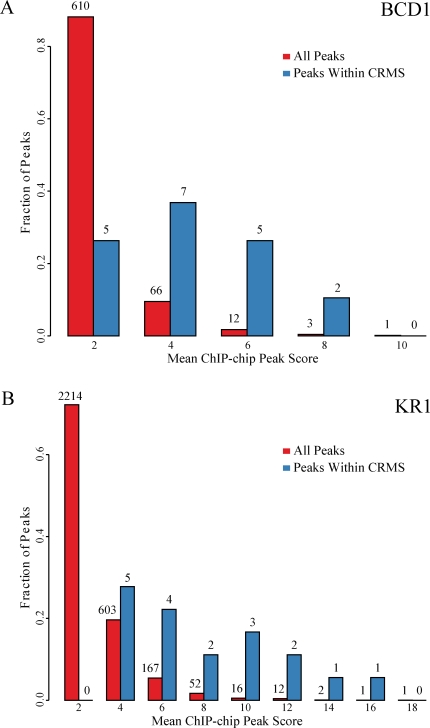
Known cis-Regulatory Modules Tend to Be among the Regions More Highly Bound In VivoThe 1% FDR bound regions for BCD1 (A) and KR1 (B) were each divided into cohorts based on primary peak window score (x-axis). The fraction of all bound regions in each cohort (red bars) and fraction of bound regions in each cohort in which the primary peak is contained within a CRM known to be regulated by the A-P factors (blue bars) are shown. The number of bound regions in each cohort is given above the bars.